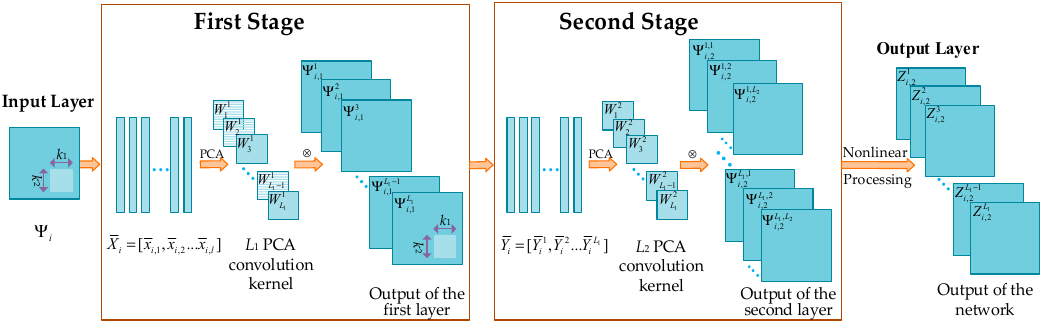
Figure 1. Diagram of two-layer PCANet.